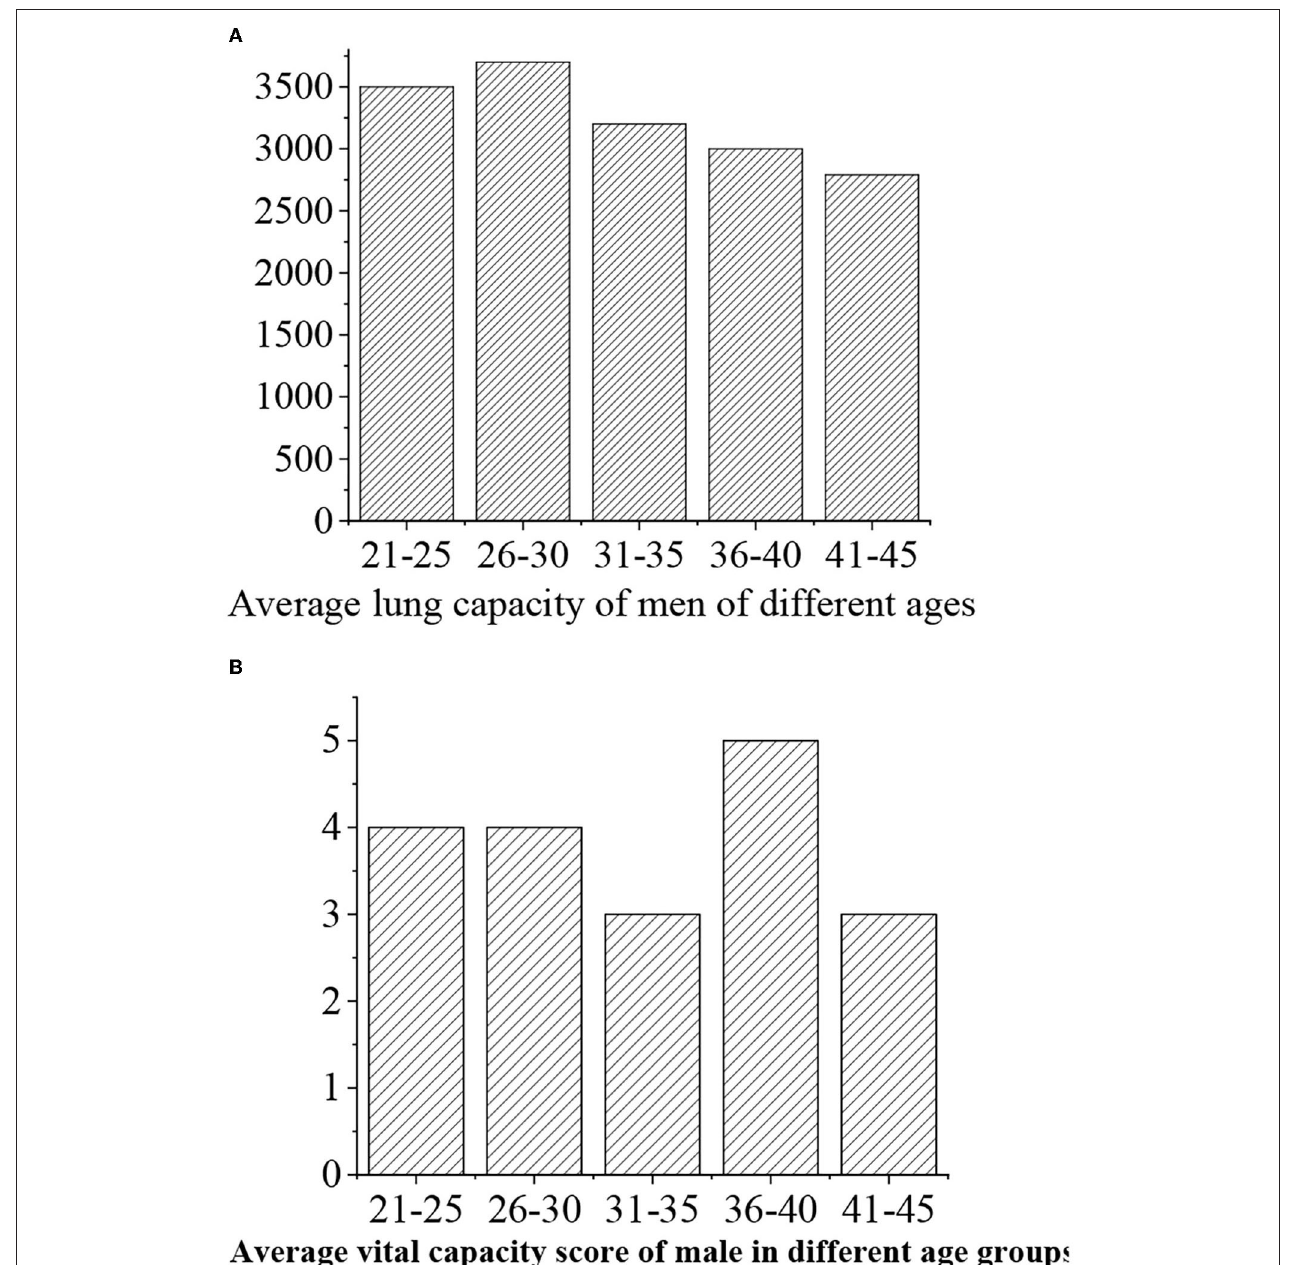
FIGURE 12 | (A) Statistical vital capacity for men of different ages. (B) Vital capacity